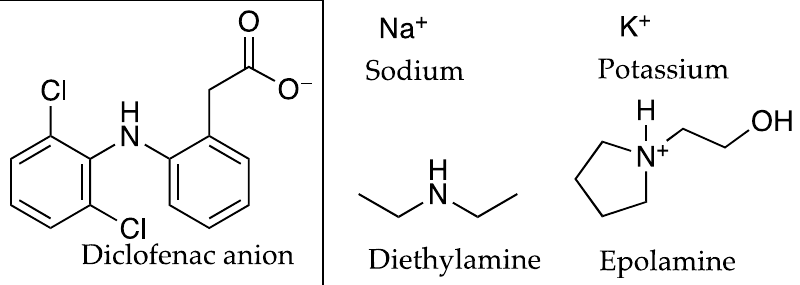
Figure 8. DIC anion with inorganic counter cations sodium and potassium and organic counter cations diethylamine and epolamine.